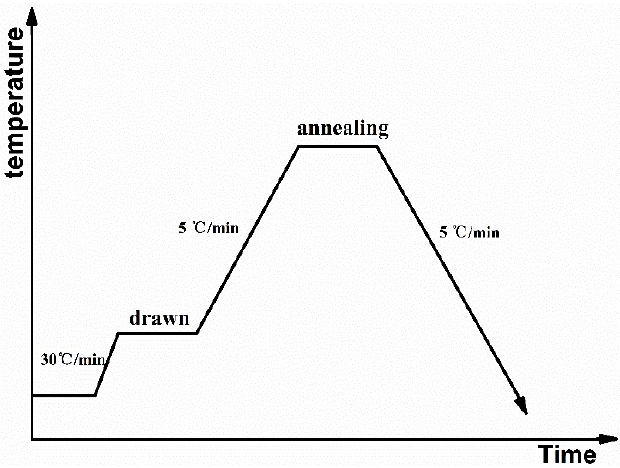
Table 1. Code of PLLA/PDLA blend fibers.